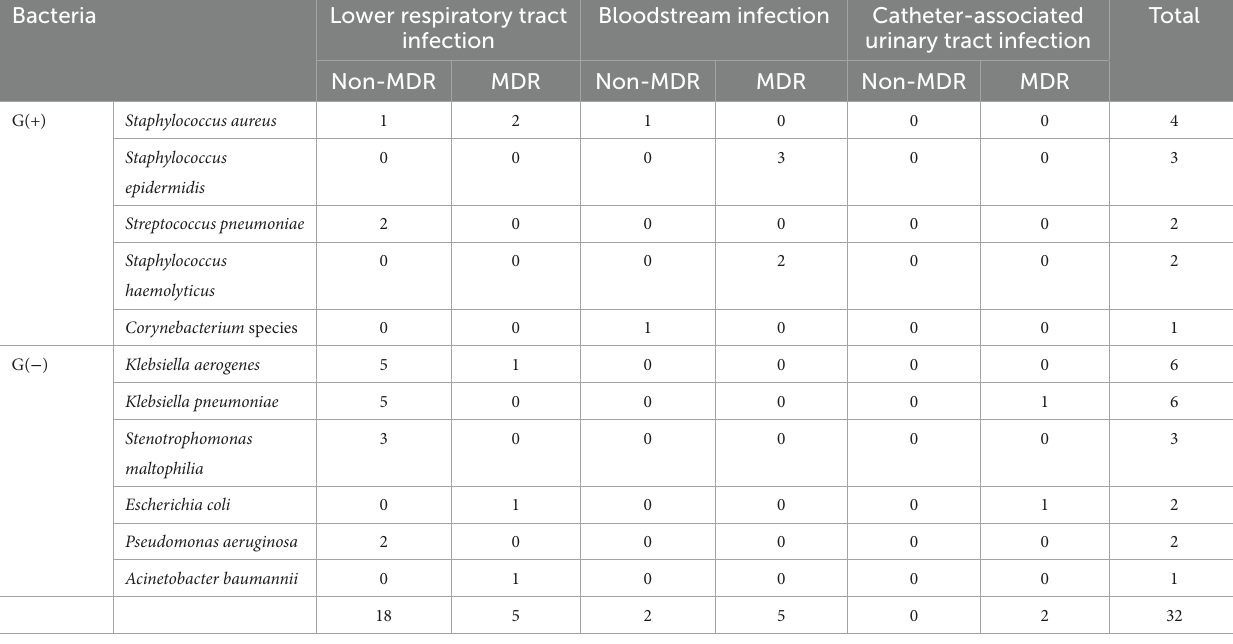
TABLE 3 Source of superinfection and microbiology in critically ill patients with COVID-19. Bacteria